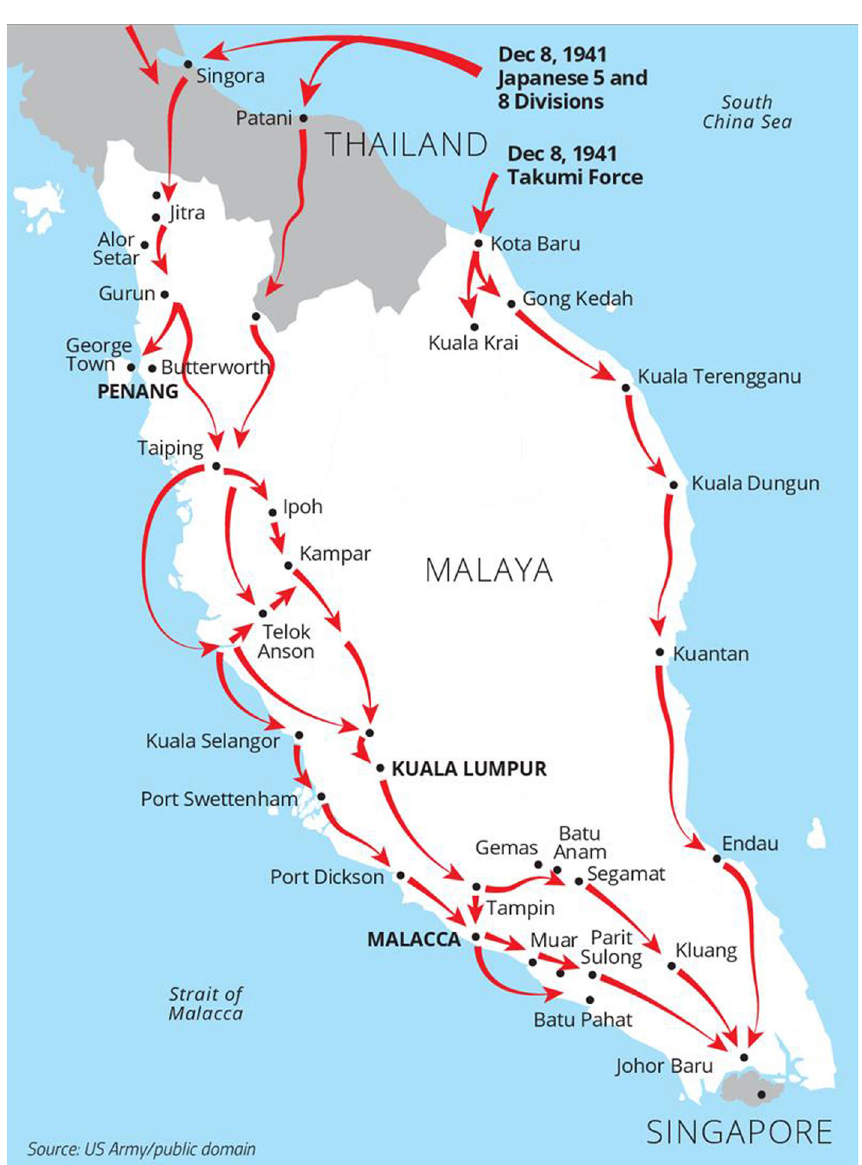
Fig. 4 Japanese invasion routes from Thailand to Malaya and then Singapore (Source: Rouwen Lin, ‘ Invasion of Malaya: First shot in the Pacific war ’ , The Star, 8 December 2016. Available at: